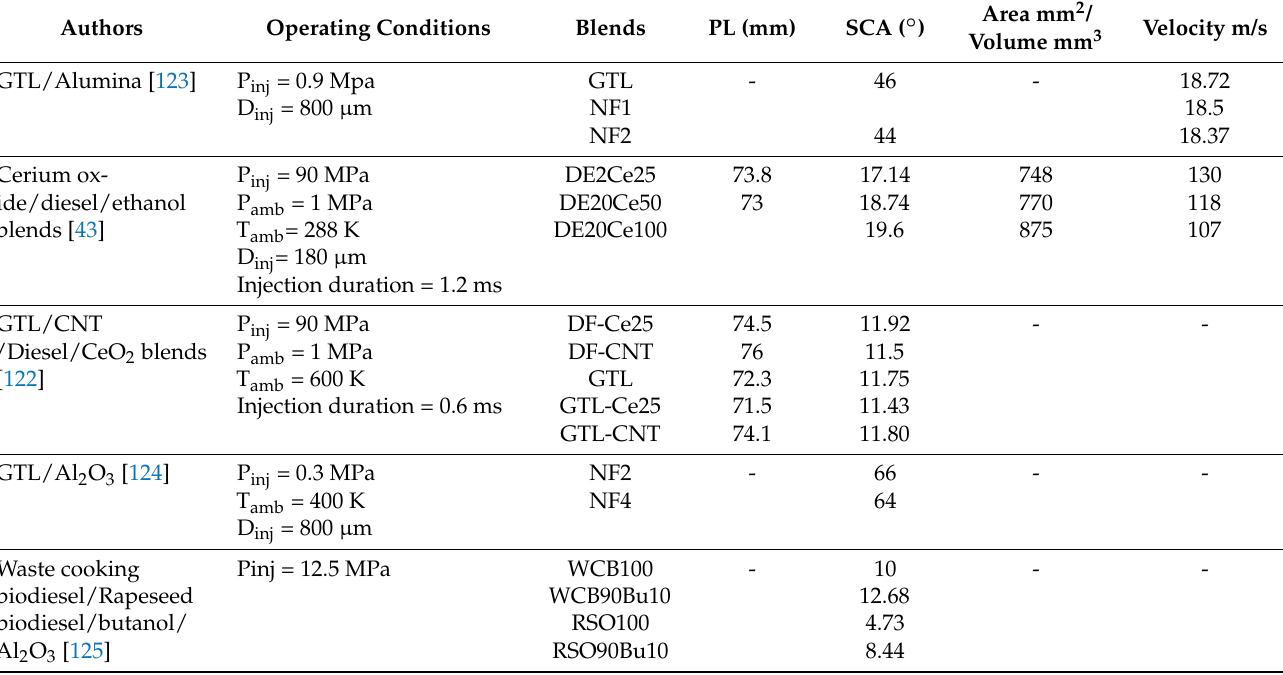
Table 9. Fuel spray characteristics of nano-based